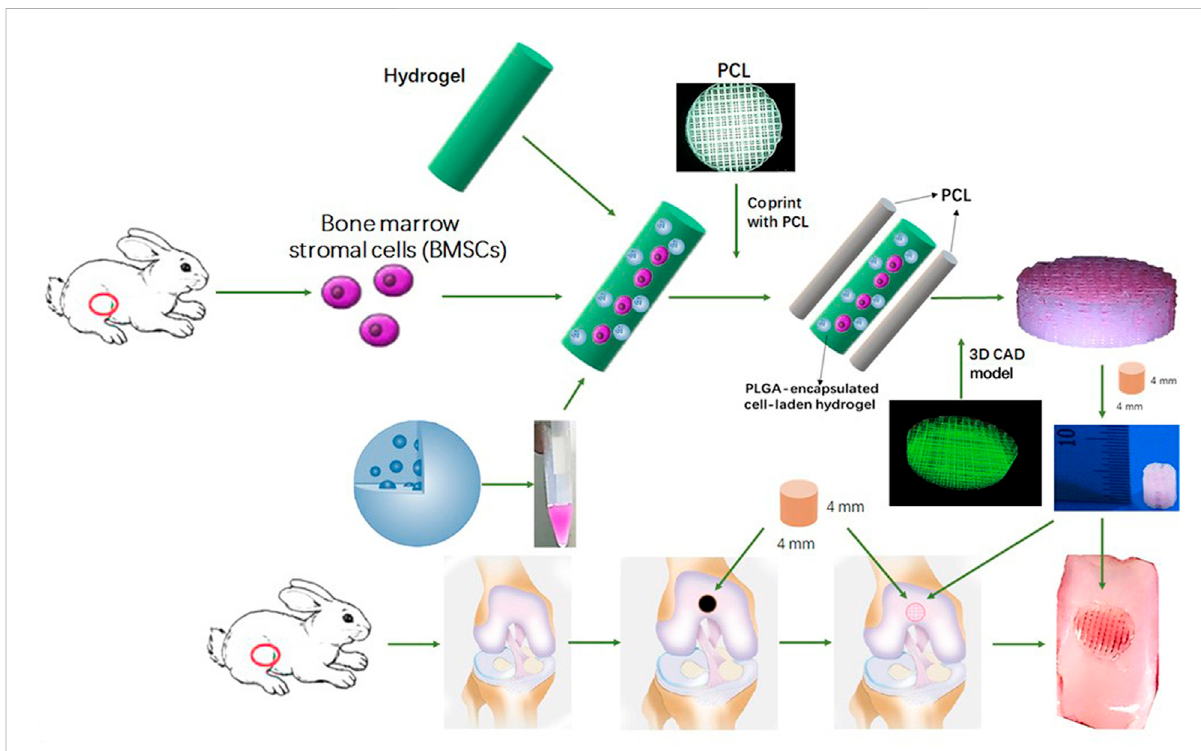
FIGURE 4 Schematic Illustration of the study design with 3D bioprinted dual-factor releasing and gradient-structured MSC-laden constructs for articular cartilage regeneration in rabbits. Schematic diagram of construction of the anisotropic cartilage scaffold and study design (Sun et al.,